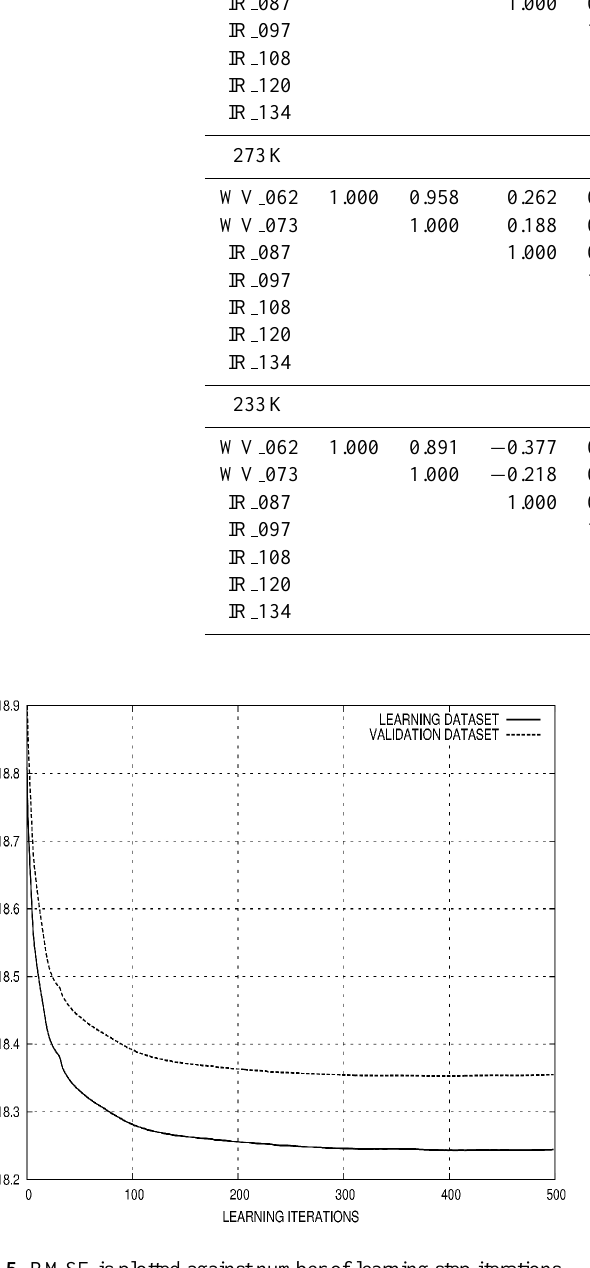
Figure 5. RMSE is plotted against number of learning step iterations. Learning (resp. validation) dataset is plotted in plain (resp. dashed) line.